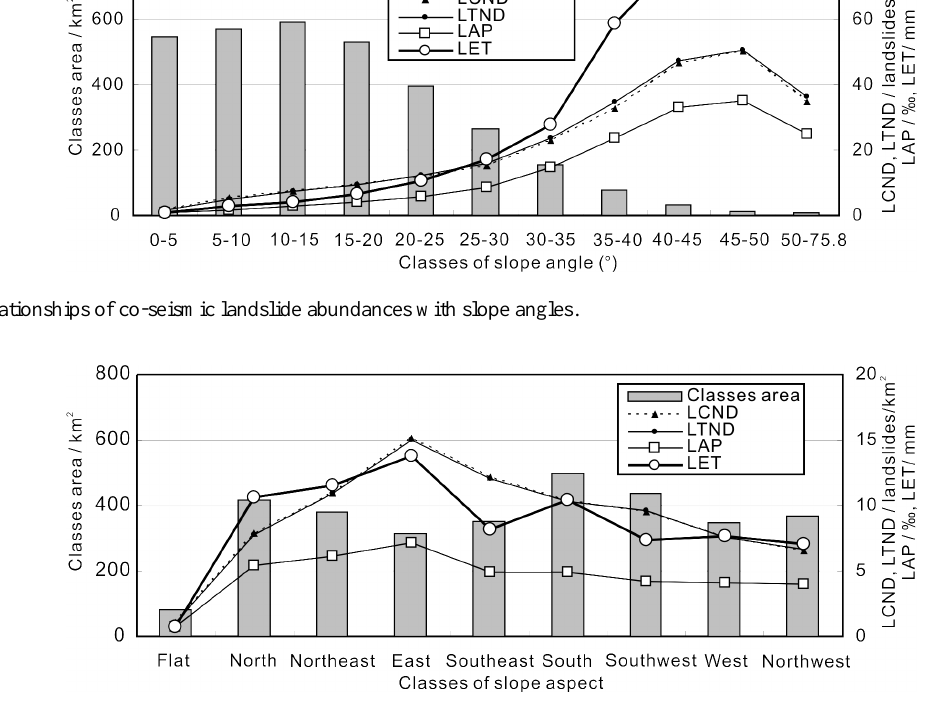
Slope curvature represents the shapes of the slopes. In our analysis using ArcGIS software, it is calculated as the sec- ond derivative of the surface (Moore et al., 1991). Positive values mean convex slopes, negative values indicate concave slopes, and values close to zero represent flat-surface